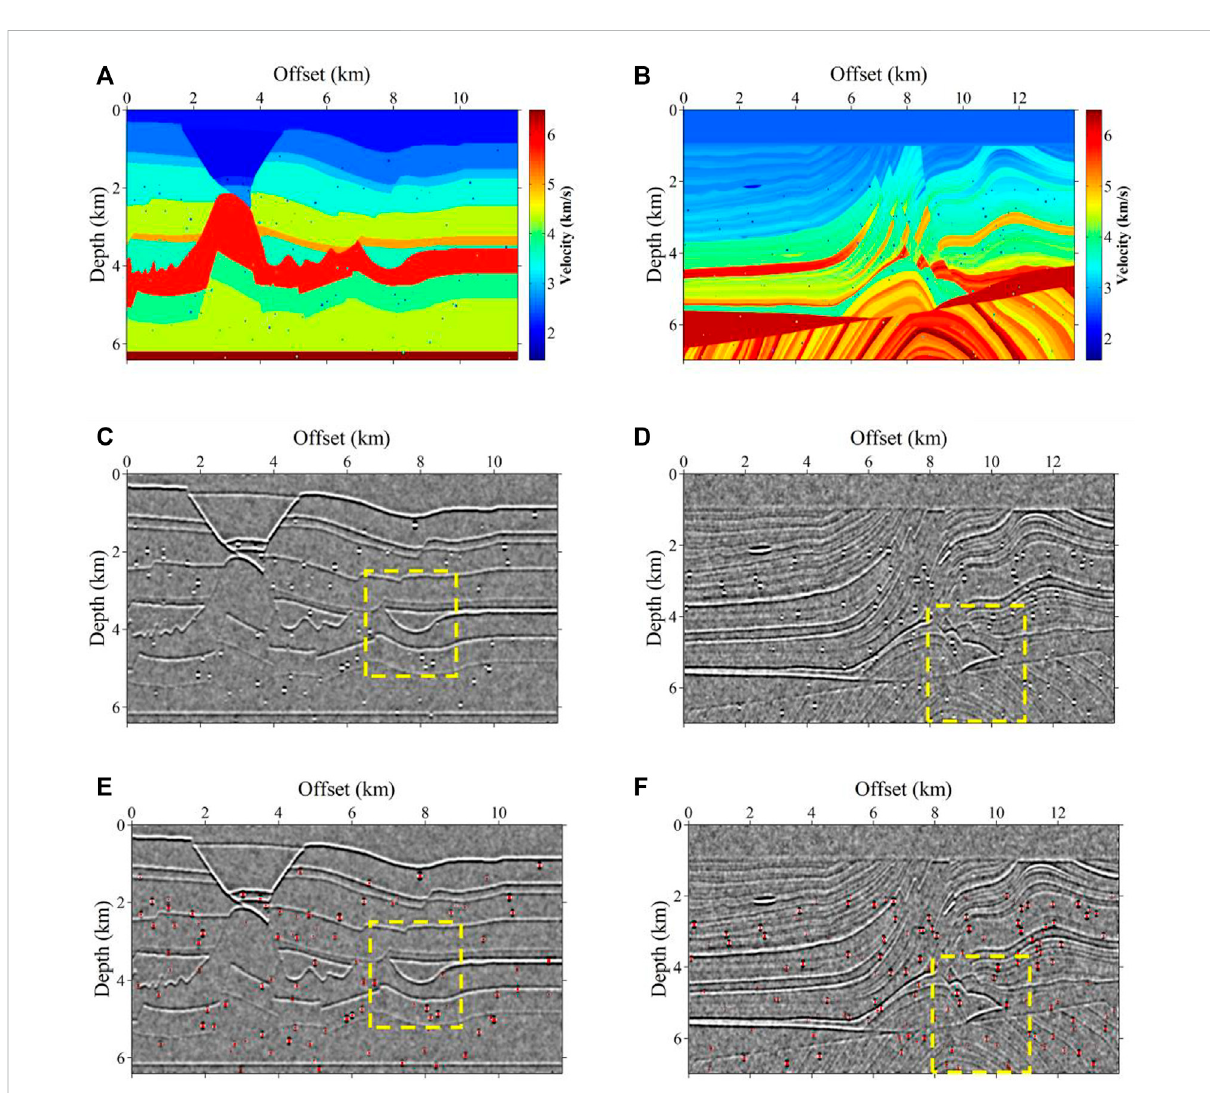
FIGURE 9 The prediction results on the testing data set with random noise. The symbols are the same as in Figure 8.